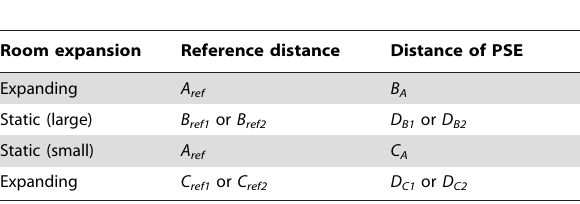
Table 1. Labels used for reference distances and points of subjective equality